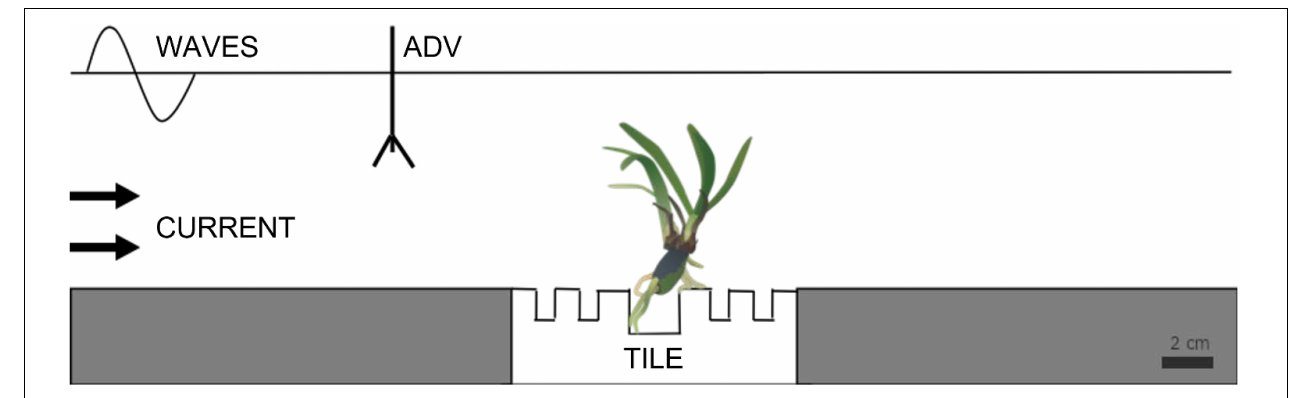
FIGURE 2 | Schematic representation of the experimental setup to test the resistance of root adhesion to the substrate in the current and wave flumes (ADV, acoustic Doppler